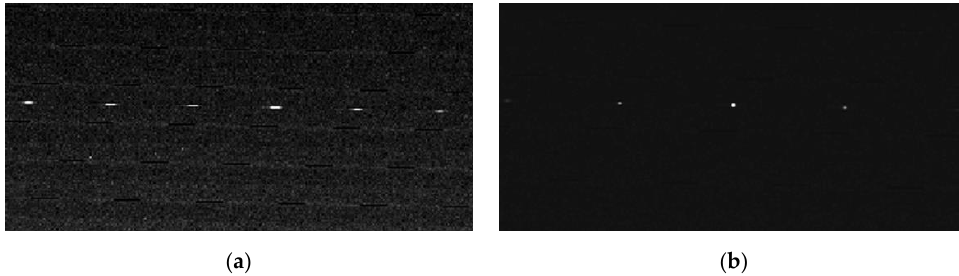
Figure 10. Images of di ff use spot collected by the COS prototype ( a ) before noise reduction, ( b ) after noise